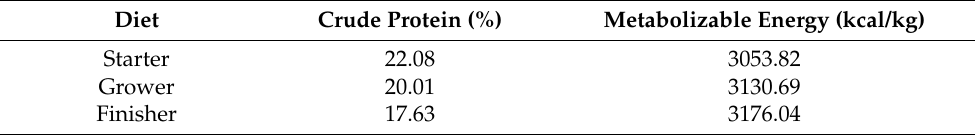
Table 1. Nutrient composition of diets used for all birds in the